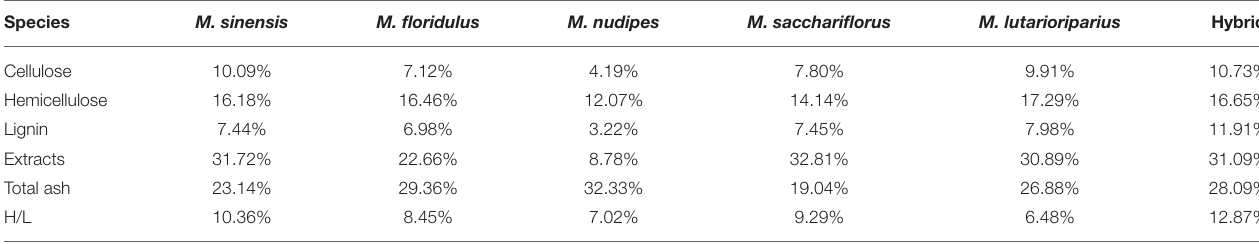
TABLE 2 | Coefficient of variation of lignocellulosic components of Miscanthus .